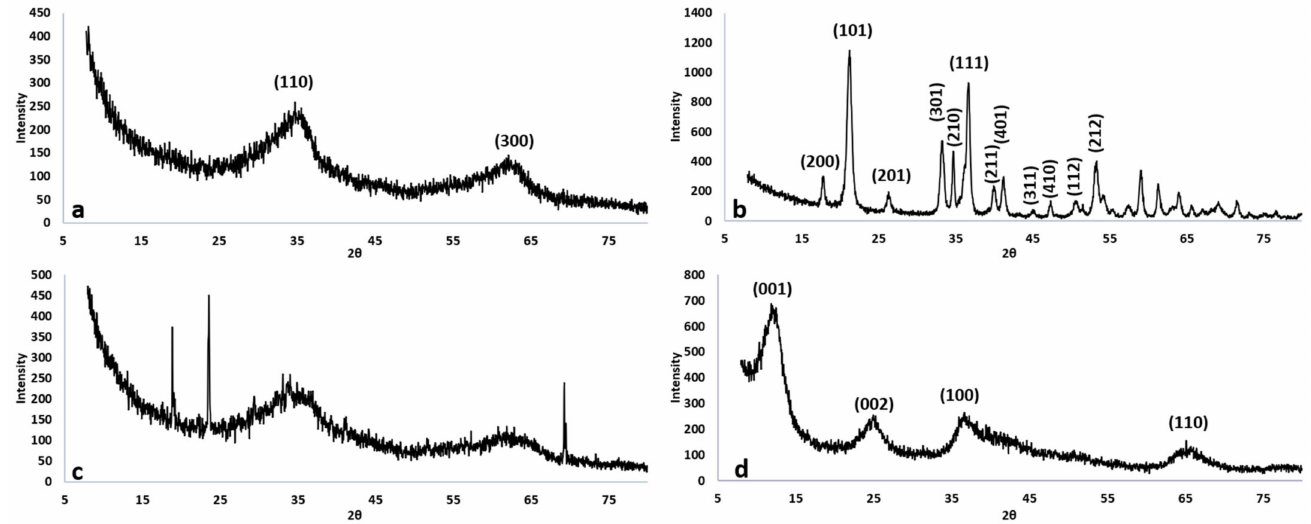
Figure 2. X-RD patterns of ( a ) ferrihydrite, ( b ) goethite, ( c ) AMO and ( d )